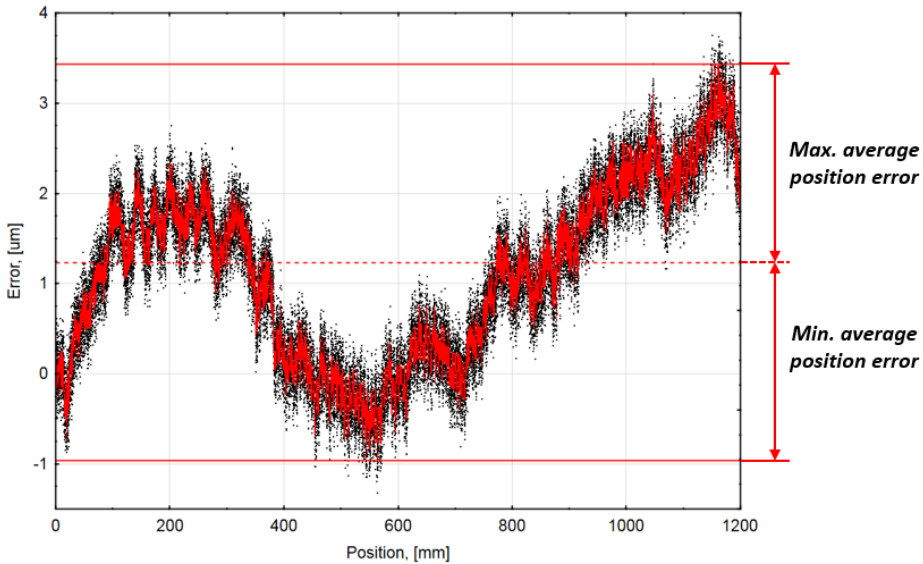
Figure 4. Accuracy graph at 20 °C ambient temperature. (Black dots—the measured error values at corresponding positions; Red curved line—the resulting average position error curve).